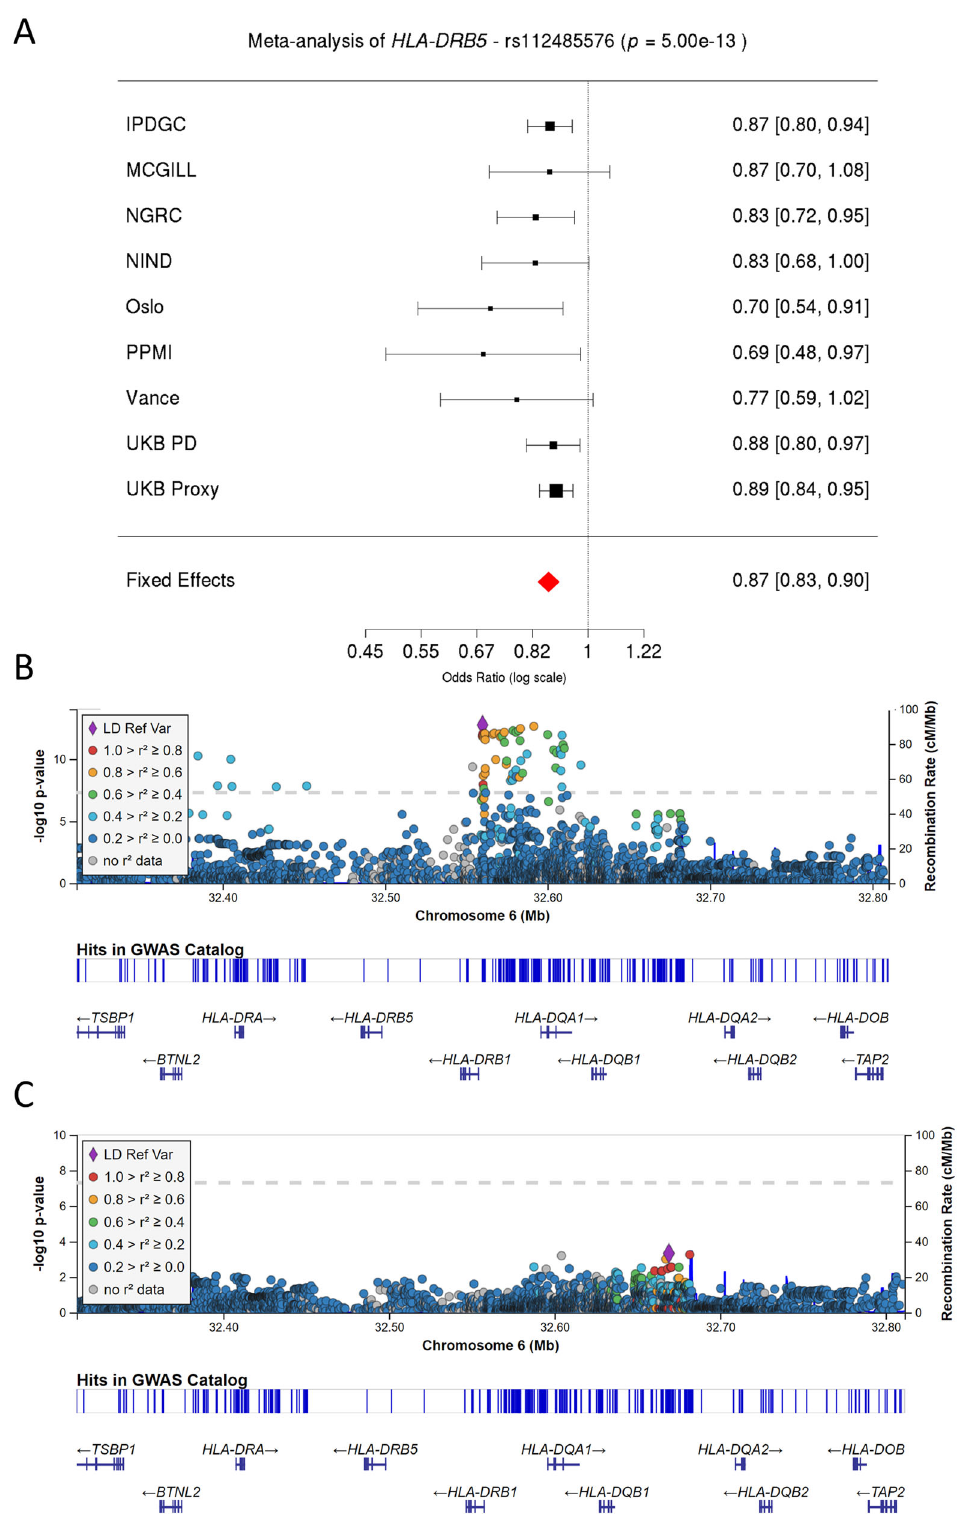
Fig. 1 Validation of previously associated top HLA locus SNP (rs112485576) in our cohort. A Forest plot describing the effect size and 95% con fi dence interval of rs112485576 for each cohort and fi xed-effect meta-analysis. B , C Two LocusZoom plots highlighting the signi fi cant variants before ( B ) and after ( C ) the conditional analysis on rs112485576. Dashed lines correspond to the signi fi cance threshold. Linkage disequilibrium values are shown with respect to the most signi fi cant SNP in the